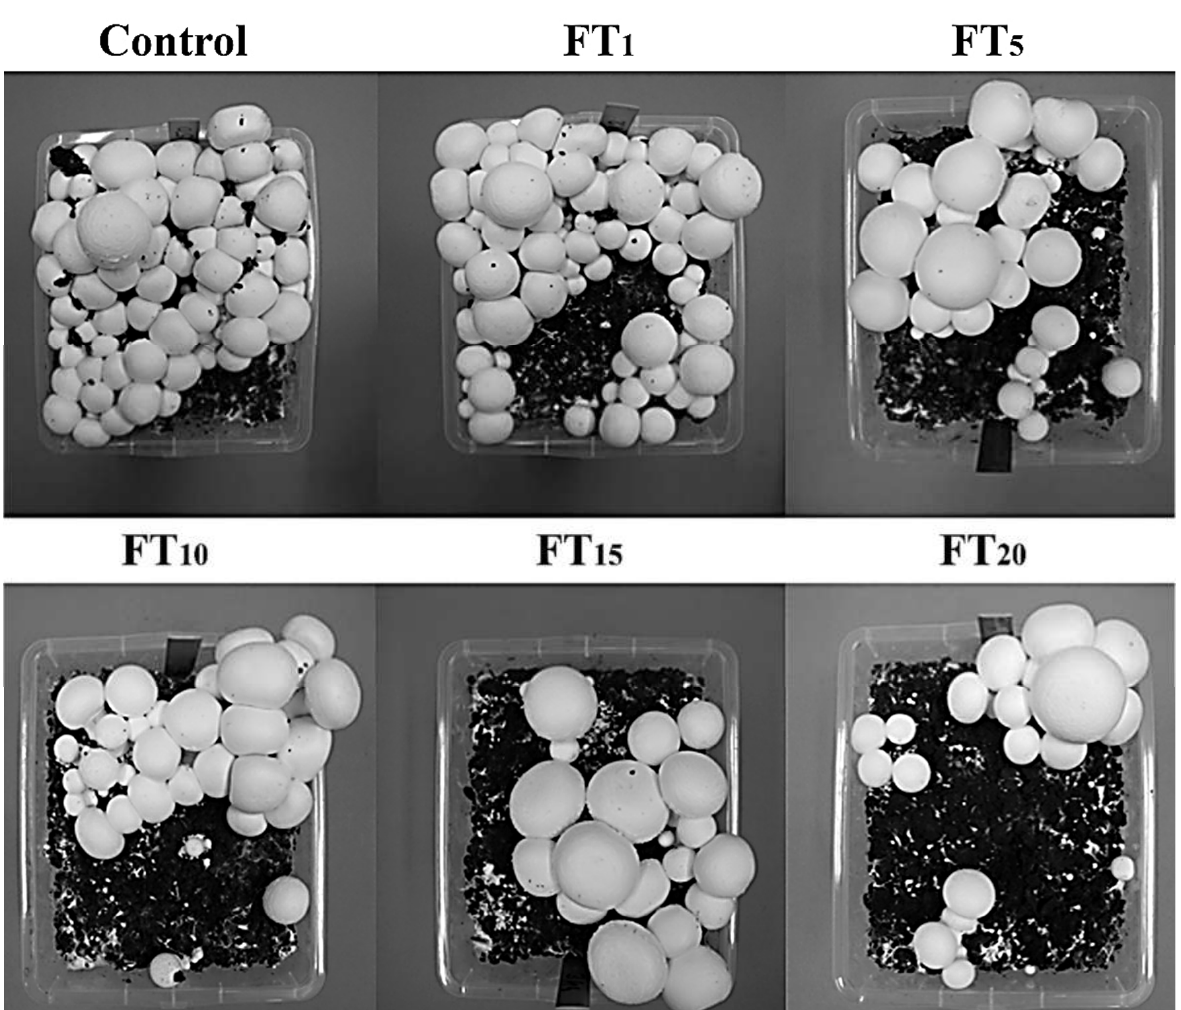
Figure 2. Macroscopic characteristics of Agaricus bisporus fruit bodies growing in particular experi- mental systems.